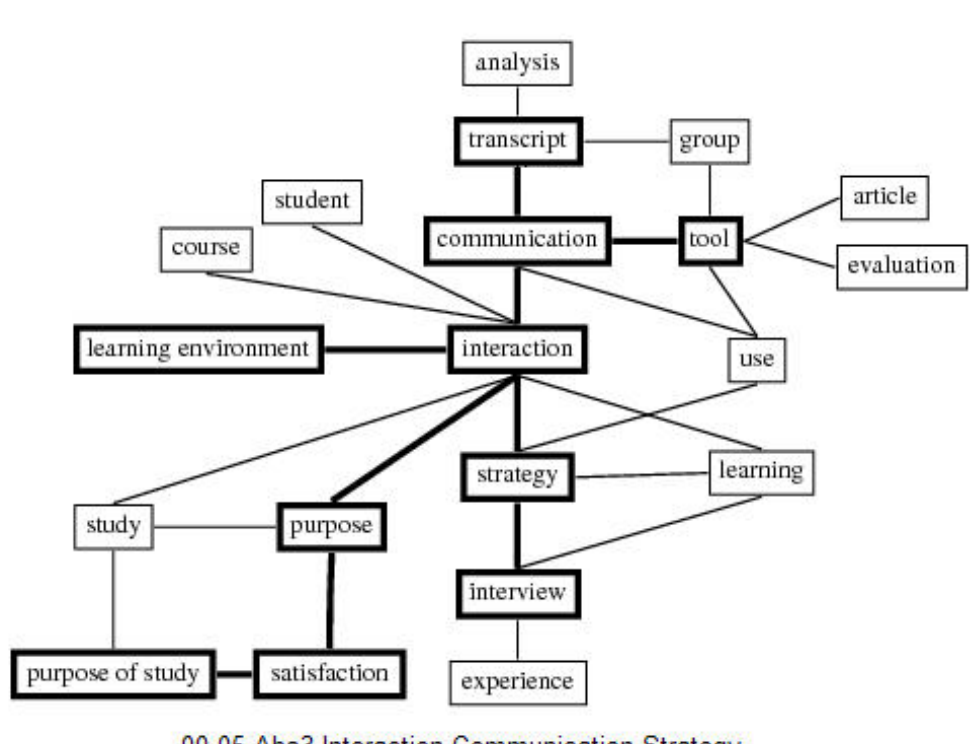
Figure 3 . 00-05-Abs3-Interaction-Communication-Tool lexical map. Emergence of